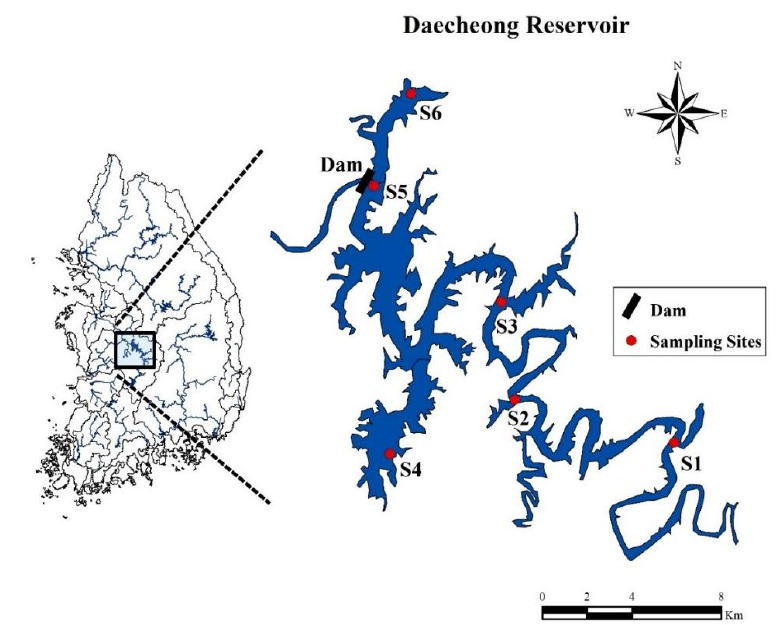
Figure 1. The map is showing the sampling sites of Daecheong Reservoir. S1 and S2—riverine zone (Rz), S3—transitional zone (Tz), S5—lacustrine zone (Lz), S4 (IT1) and S6 (IT2)—intake tower of drinking water